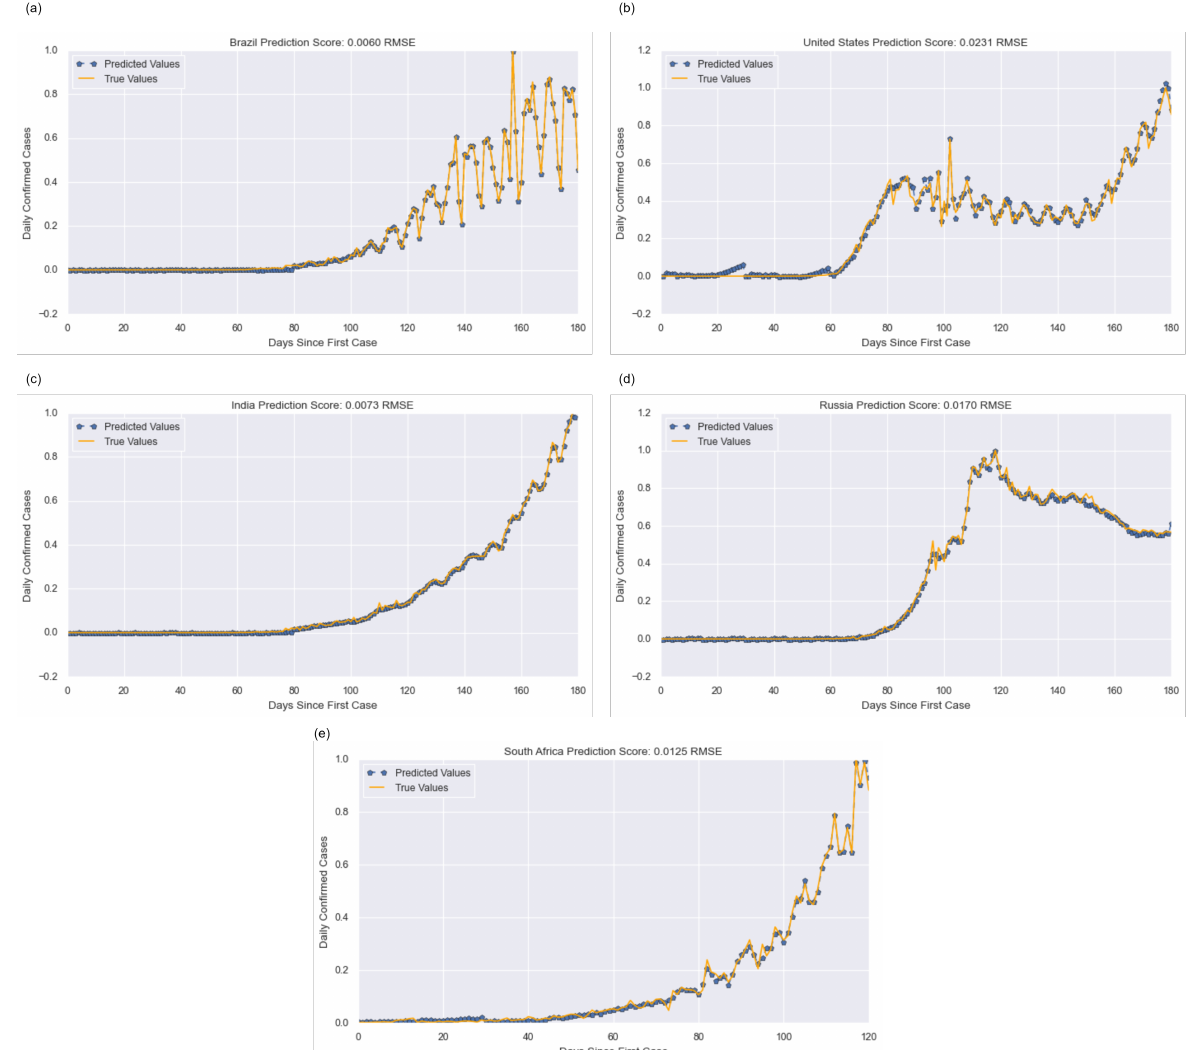
Figure 14. Validation results of LSTM models for daily COVID-19 cases predictions for countries (Brazil (a), USA (b), India (c), Russia (d) and South Africa (e)) of Critical